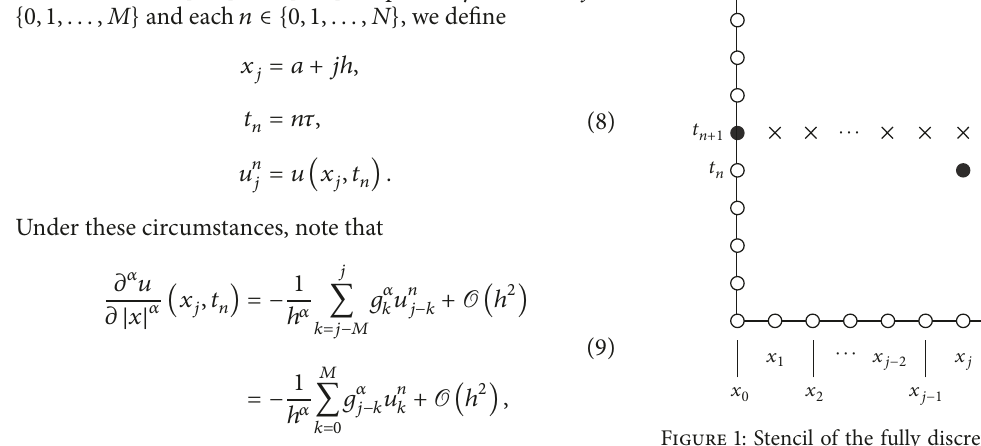
Figure 1: Stencil of the fully discrete model (11). The black circles represent the known solutions at the time 𝑡 𝑛 and at the boundary, while the crosses denote the unknown approximations at the time 𝑡 𝑛+1